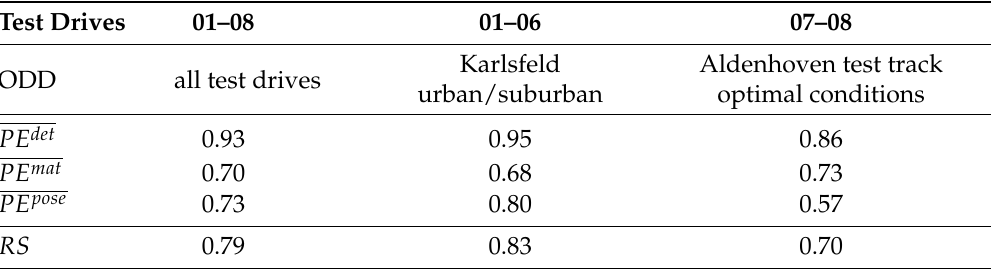
Table 5. Robustness score composition for all test drives and clustered by test drive location and characteristics.